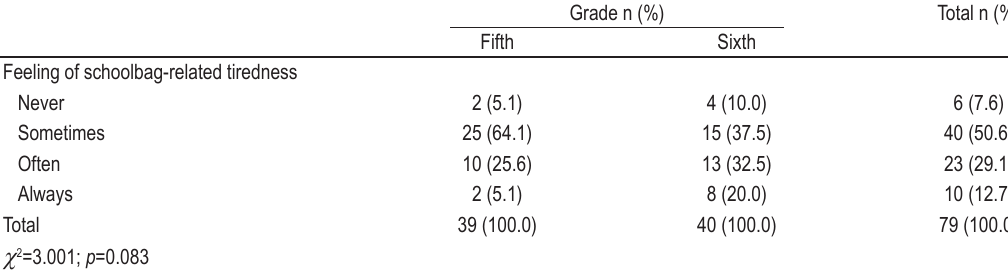
TABLE 4. Feeling of tiredness related to schoolbag